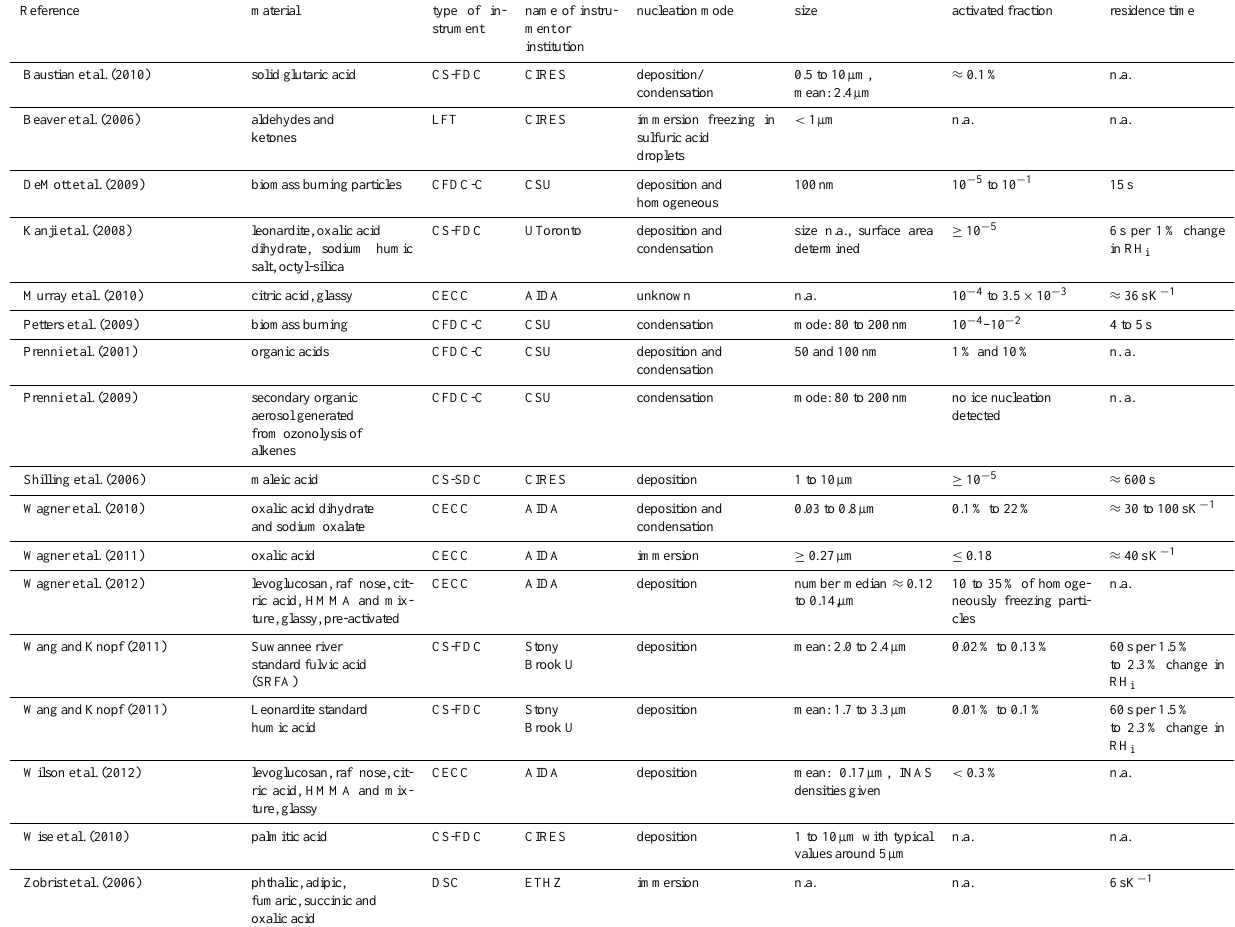
Table 5. Laboratory experiments with organic acids, humic-like substances and biomass burning